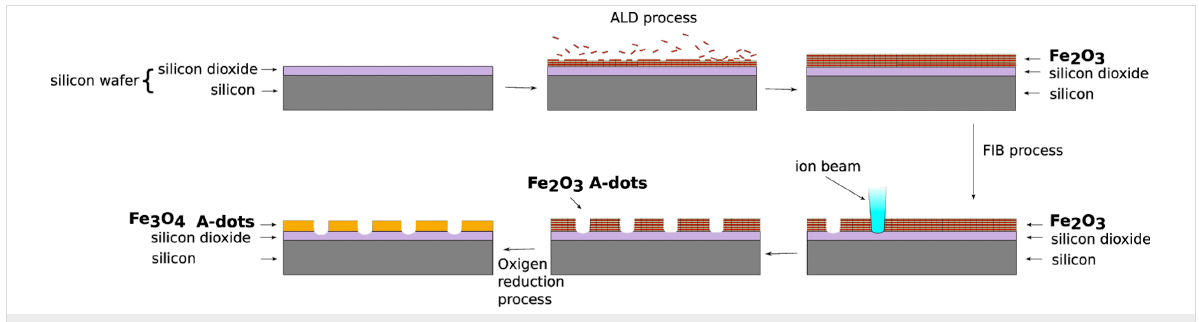
Figure 1: Outline of the AFIR process. Si(100) wafers with a native layer of SiO 2 were coated with Fe 2 O 3 . Antidot arrays were directly etched in the continuous films of Fe 2 O 3 using an IonLine FIB machine. The Fe 2 O 3 antidot arrays are thermally reduced whereby Fe 3 O 4 antidot arrays are obtained.